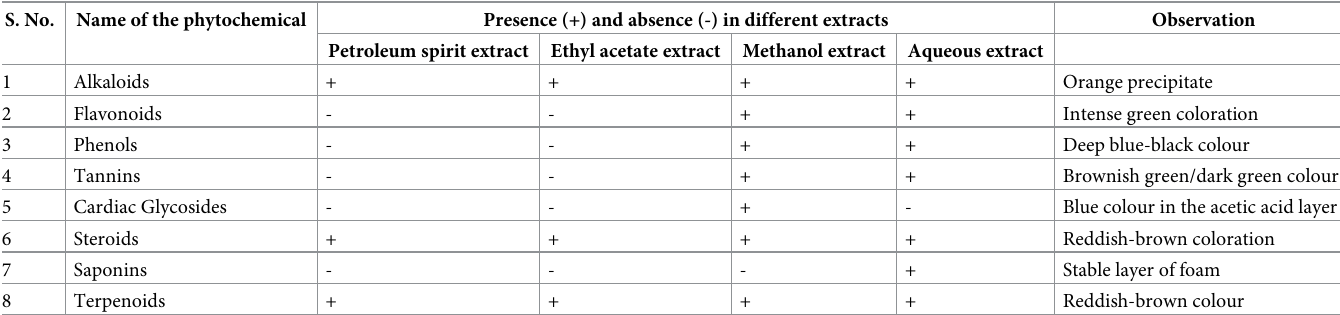
Table 1. Results of phytochemical screening of petroleum spirit, ethyl acetate, methanol, and aqueous extracts of N . sativa seeds. S. No. Name of the